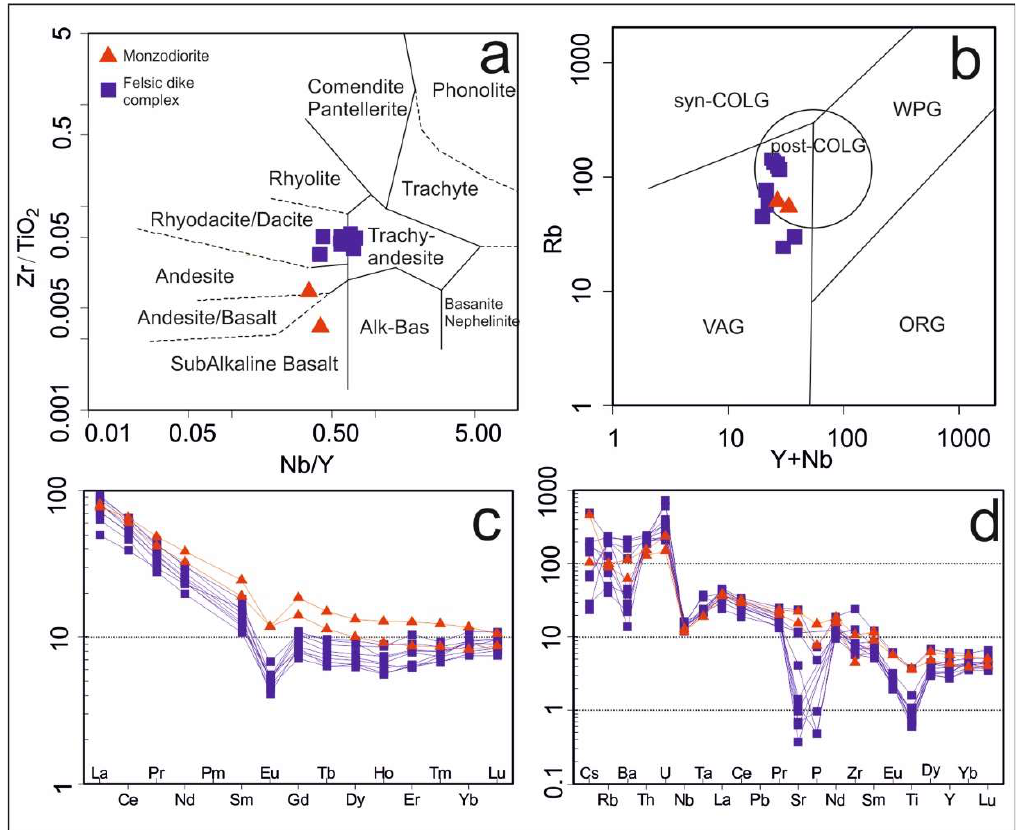
Figure 5. ( a ) Classification of the studied magmatic rocks based on the Zr/TiO 2 versus Nb/Y diagram after Winchester and Floyd [29]; ( b ) Rb versus Y + Nb diagram after Pearce and Harris [30]. VAG, Volcano Arc Granite; Syn-COLG, Syn-collision Granite; WPG, Within-Plate Granite; ORG, Ocean Ridge Granite, post-COLG, Post-collision Granite. The field of post-collisional granite (Post-COLG) is from Pearce [31]; ( c ) chondrite-normalized rare earth elements after Boynton [32] and ( d ) primitive mantle trace elements- normalized patterns of the studied rocks after McDonough and Sun [33].